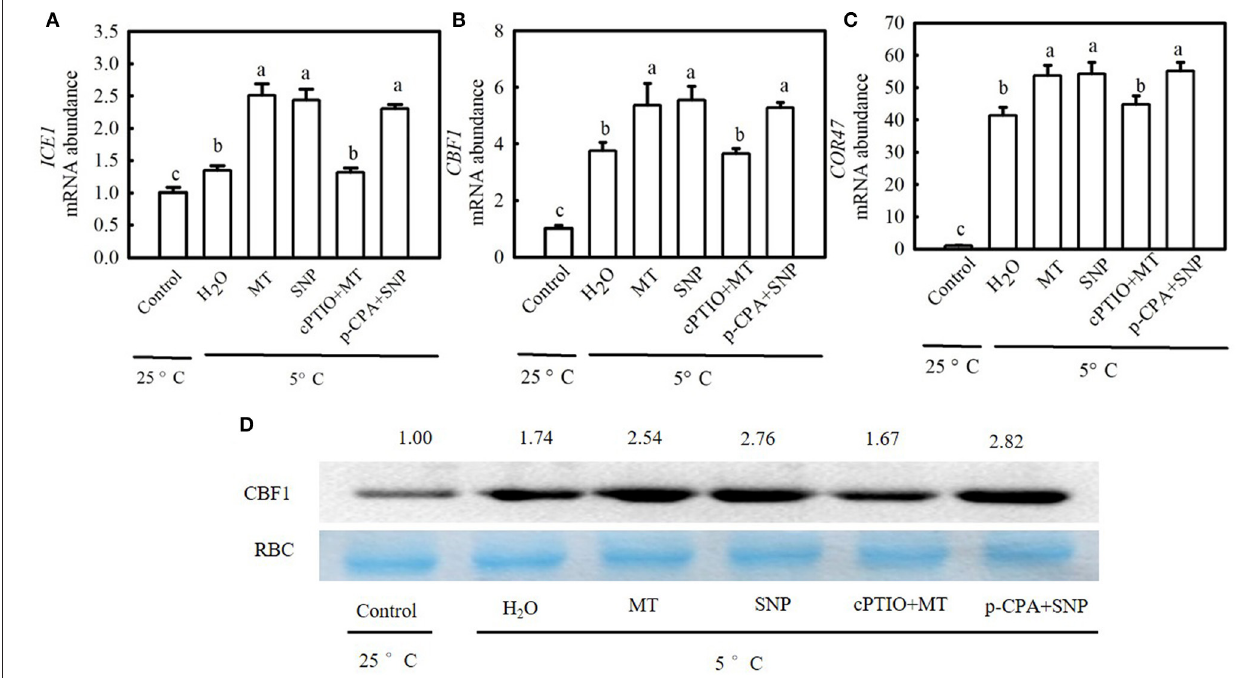
FIGURE 11 | Interactive effects of MT and SNP on the relative mRNA expression of cold-responsive ( COR47 ) genes and the protein level of C-repeat-binding factor ( CBF1 ) in cucumber seedlings under cold stress. (A–C) Relative mRNA expression of inducer of CBF expression ( ICE1 ), CBF1 , and COR47 , respectively. (D) CBF1 protein level. Three-leaf stage seedlings were foliar sprayed with 100 µ M MT, 75 µ M SNP, 100 µ M cPTIO + 100 µ M MT, 50 µ M p-CPA + 75 µ M SNP, or deionized water (control) for 24h and then exposed to 5 ◦ C for 24h. Data are represented as mean ± SD ( n = 3). Different letters indicate a significant difference between samples according to Duncan’s new multiple range test ( p <